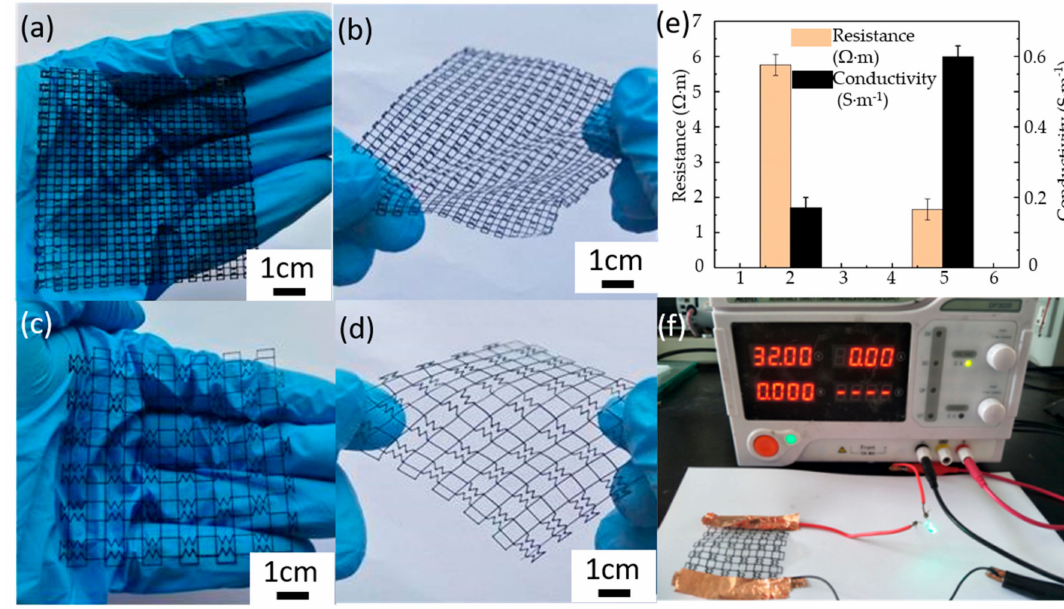
Figure 4. The anisotropic flexible mesh of the PLA / MWCNT composite: ( a , b ) the loading of 2 wt.%; ( c , d ) the loading of 5 wt.%; ( e ) the conductivity and resistance; ( f ) the conductive experiment of flexible